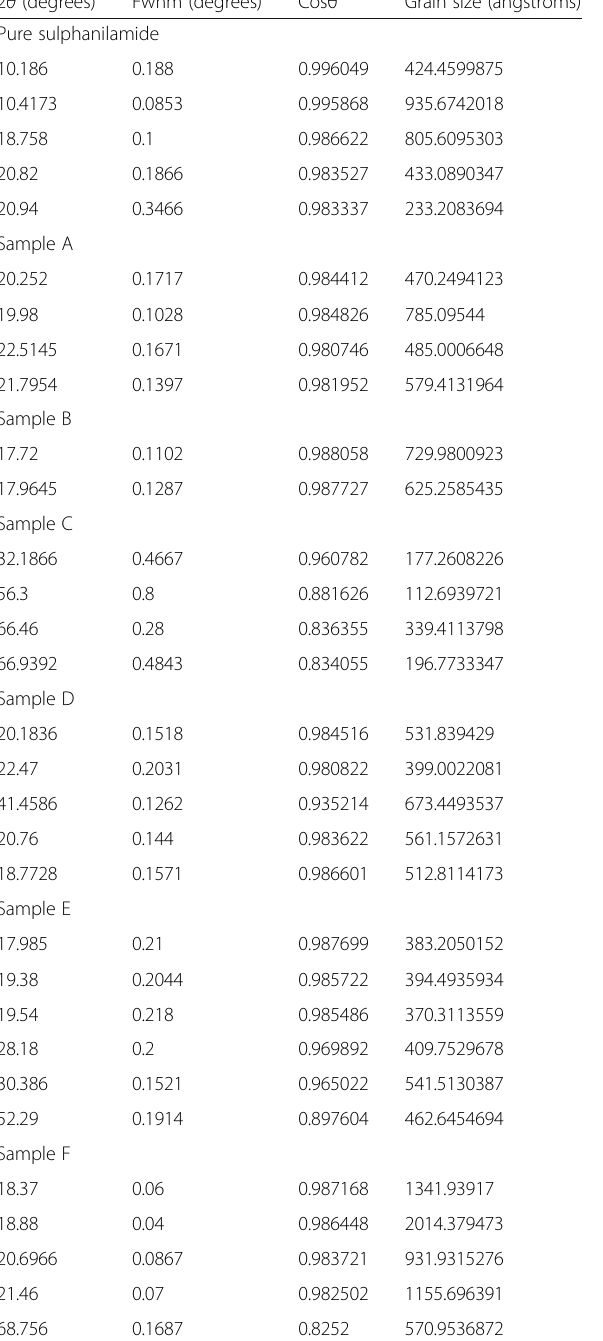
Table 6 Average crystallite size of samples obtained